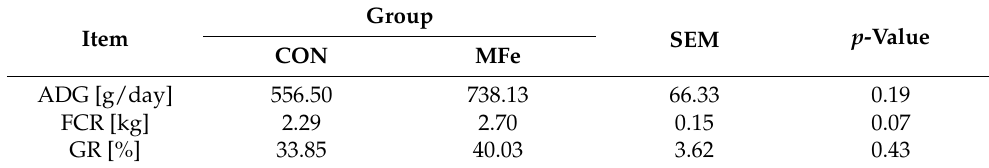
Table 2. Average daily weight gain (ADG), feed conversion factor (FCR), and growth rate (GR).